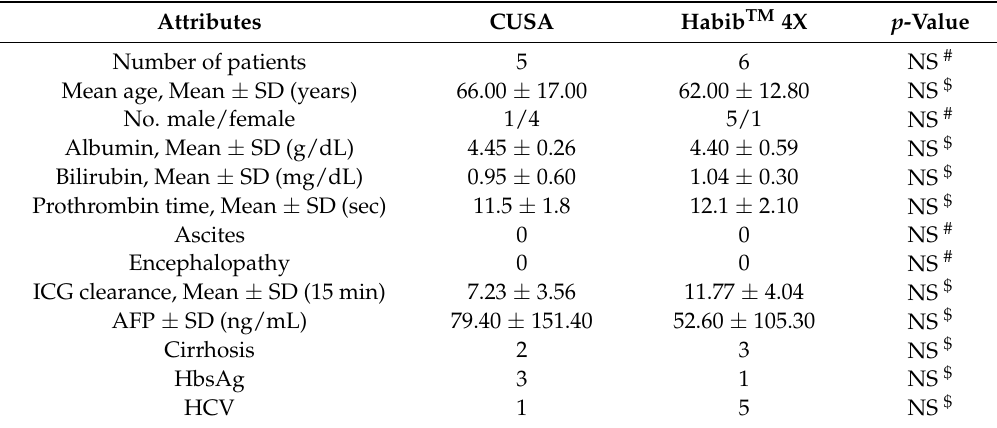
Table 1. Demographics and clinical characteristics of patients involved in the respective groups.